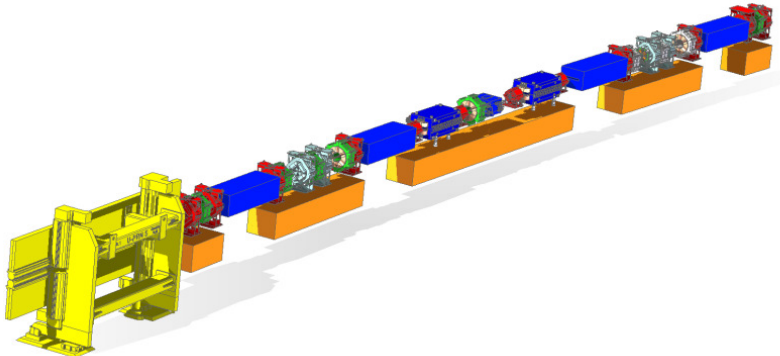
Figure 2. Planned support using girders for the magnets and other components in a 26.2 m attice cell of PETRA IV. The girders (orange) are 1 m, 3 m, and 6 m long. The displayed magnet models are artificial (modified according to [13], printed with permission from DESY).